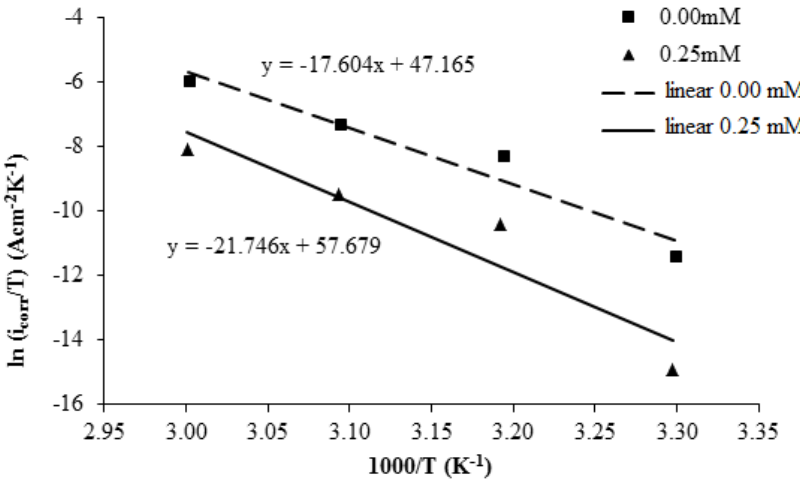
Figure 7. The situation plot for mild steel in 1.0 M H concentrations of the corrosion